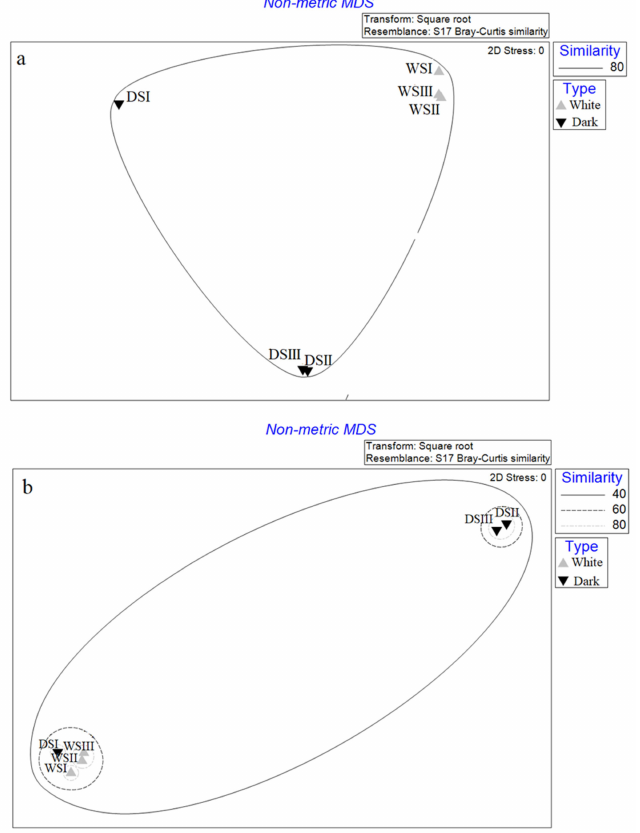
Figure 10. nMDS analysis computed on relative abundance data at phylum ( a ) and genus level ( b ) of bacterial groups. WS, white salt; DS, dark